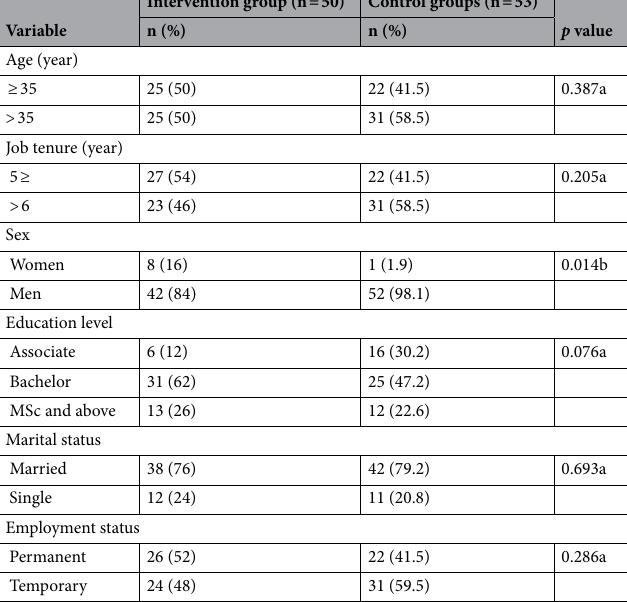
Table 2. Demographic characteristics of intervention and control groups. a Pearson Chi-Square; b Fisher’s Exact